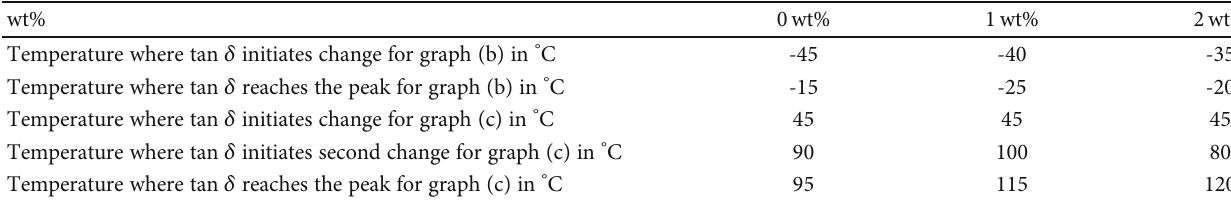
Table 4: tan δ peak temperature